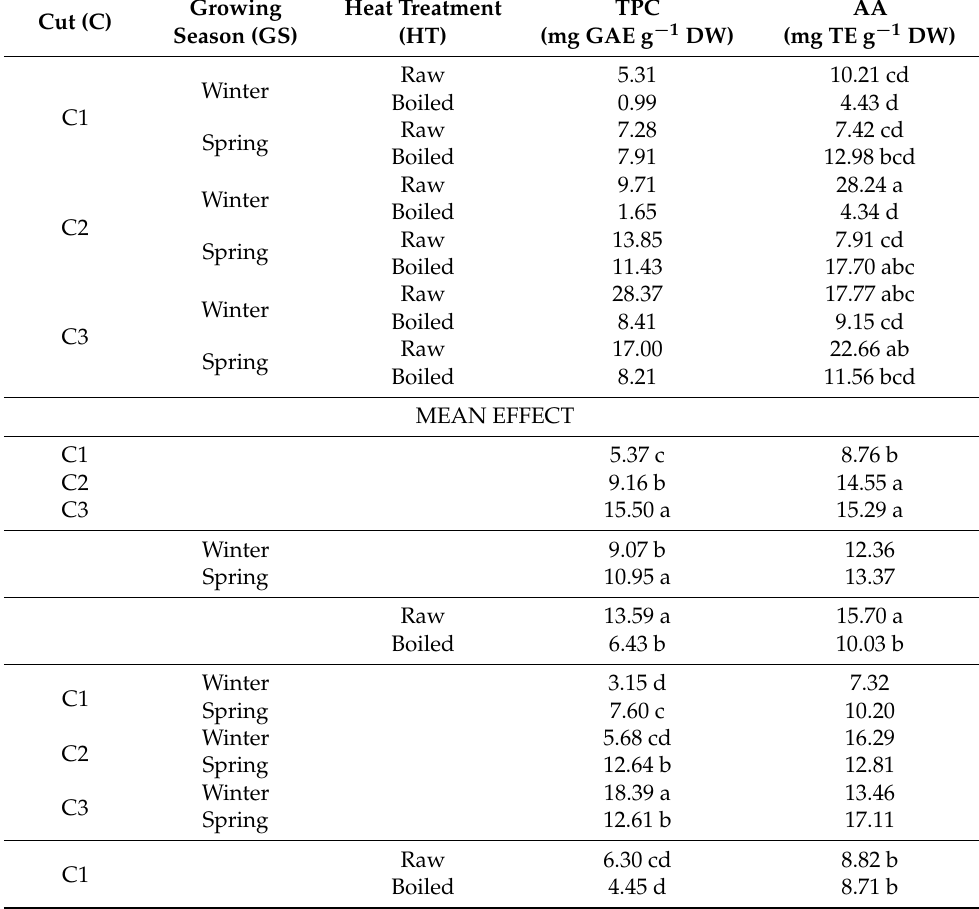
Table 2. Total phenolic content (TPC) and antioxidant capacity (AA) in raw or boiled leaves of Borago officinalis hydroponically grown under greenhouse in winter or in spring and subjected to three consecutive cuts (C1, C2, C3). Data keyed with different letters are significantly different for p < 0.05 following three-way ANOVA and Tukey’s HSD post-hoc test for the effect of growing season, cut and